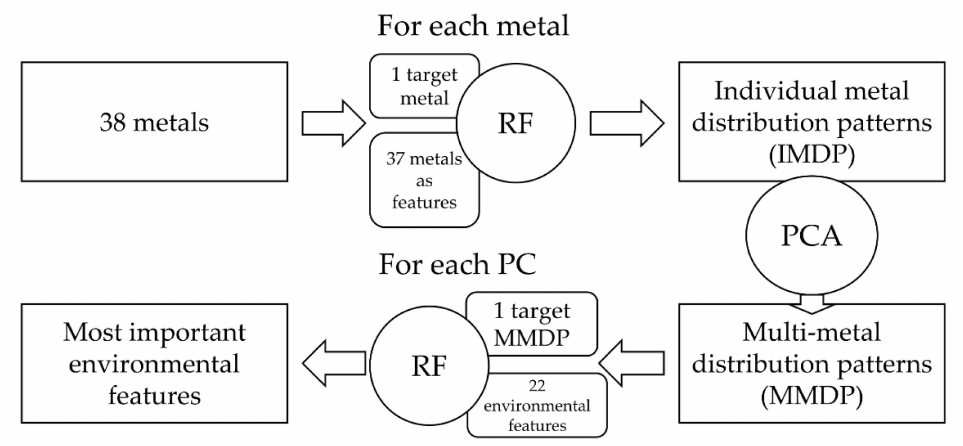
Figure 2. Overview of the research process, detailing the different steps and input